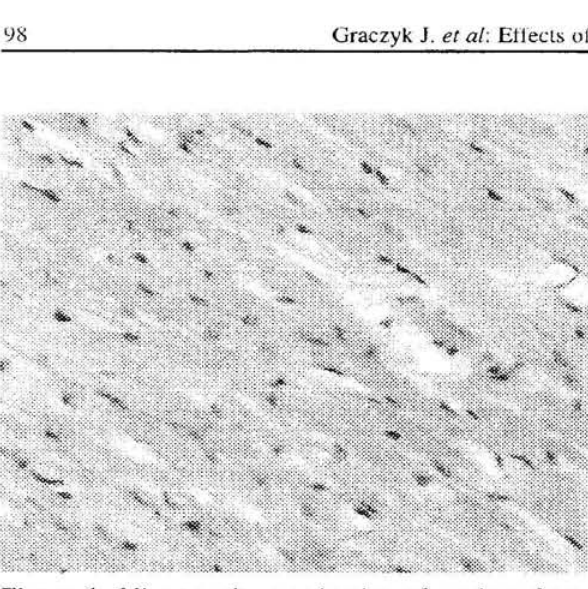
Figure 2. Microscopic examination of sections from rabbit heart after receiving doxorubicin and carnosine simultaneously